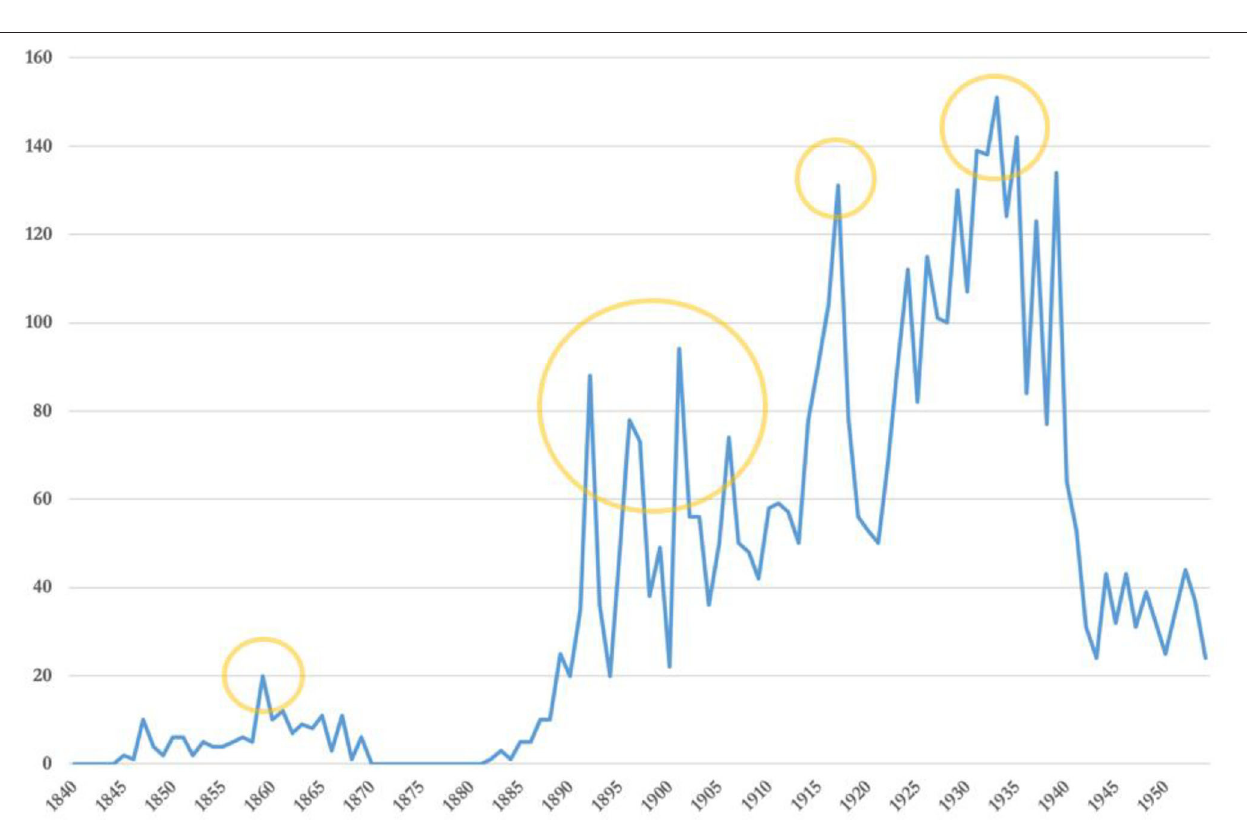
FIGURE 2 | Articles containing “concussion” in 22 Australian sporting newspapers,